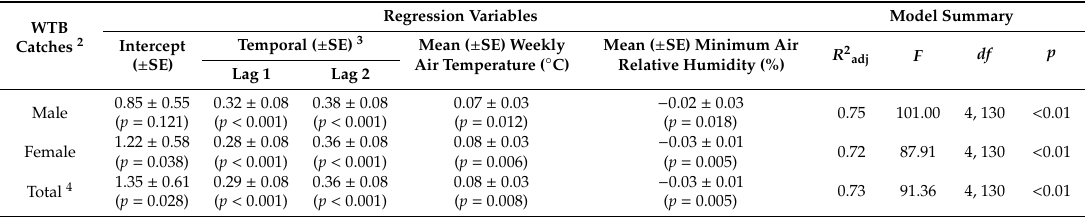
Table 2. Multiple regression models developed for 142 weekly trap catches of walnut twig beetle (WTB), Pityophthorus juglandis